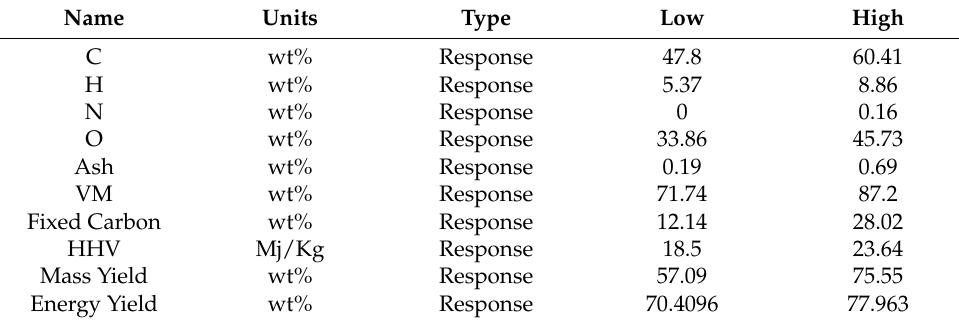
Table 3. Response factors and respective